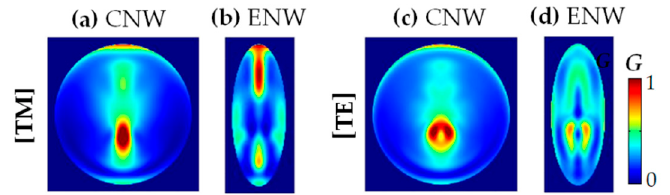
Figure 5. The normalized photogeneration rate ( G ) profiles for the CNW and ENW: ( a , b ) for TM and ( c , d ) for TE light illumination (with an identical color scale); ( a , c ) for the CNW with D = b = 500 nm and ( b , d ) for the ENW with a = 200 and b = 500 nm, respectively.